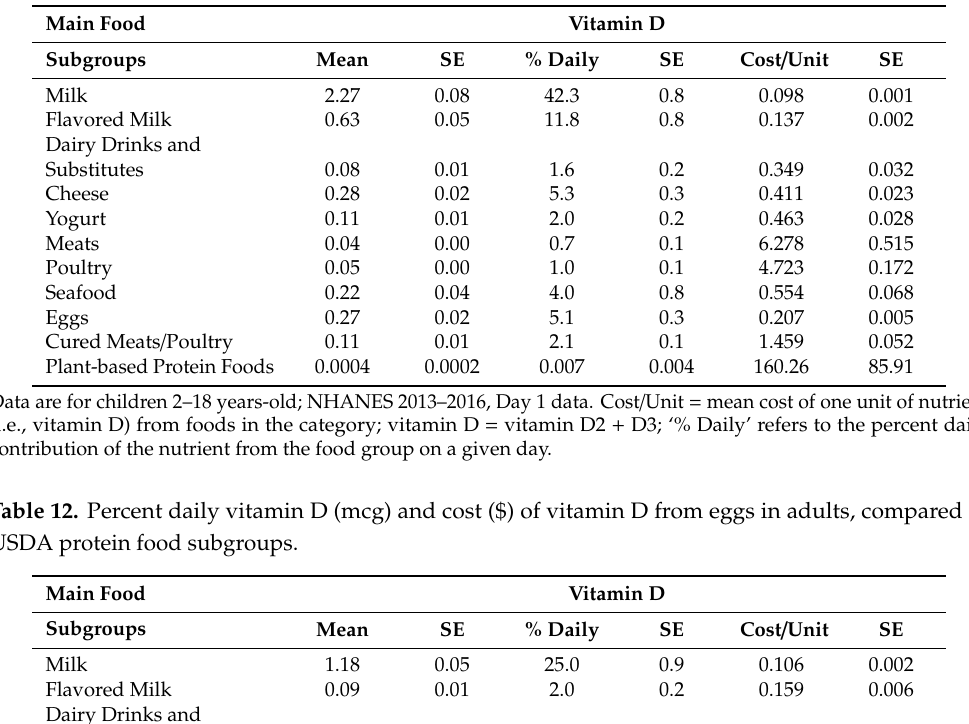
Table 11. Percentage daily vitamin D (mcg) and cost ($) of vitamin D from eggs in children, compared to USDA protein food subgroups.